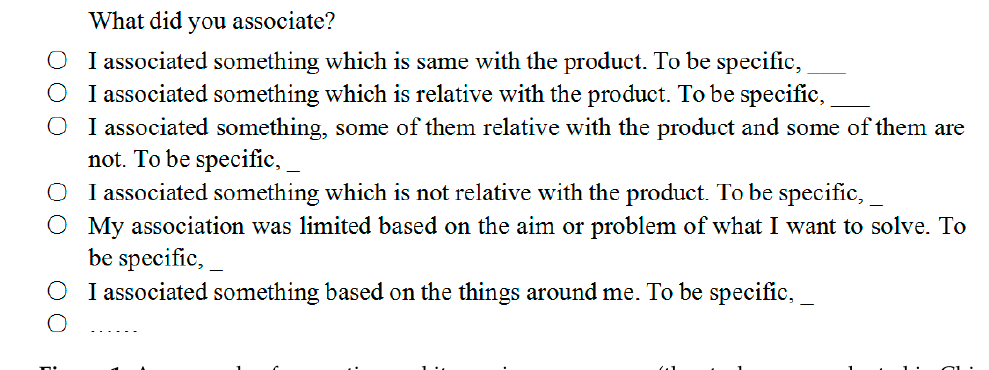
Figure 1. An example of a question and its semi-open answers (the study was conducted in Chinese, and the example is a translated version).